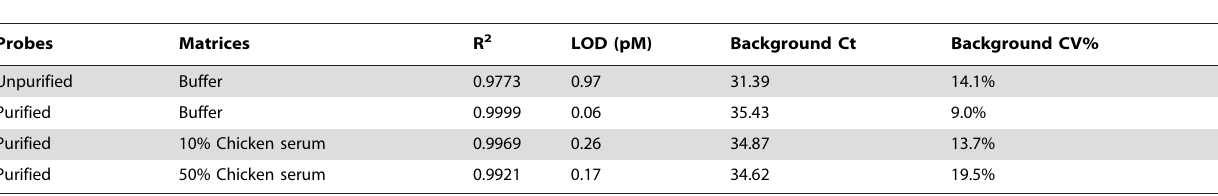
Table 1. Summary of solution phase PLA for detection of IL8 proteins in PLA buffer or in 10% or 50% chicken serum.